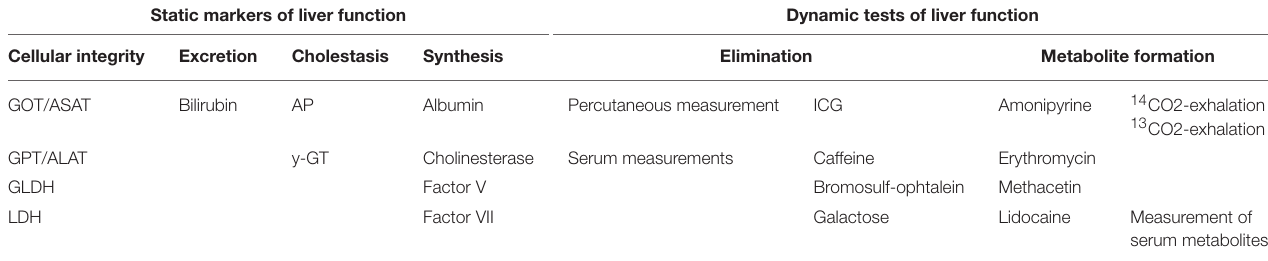
TABLE 10 | Static and dynamic tests of liver function [modified according to Sakka (93,